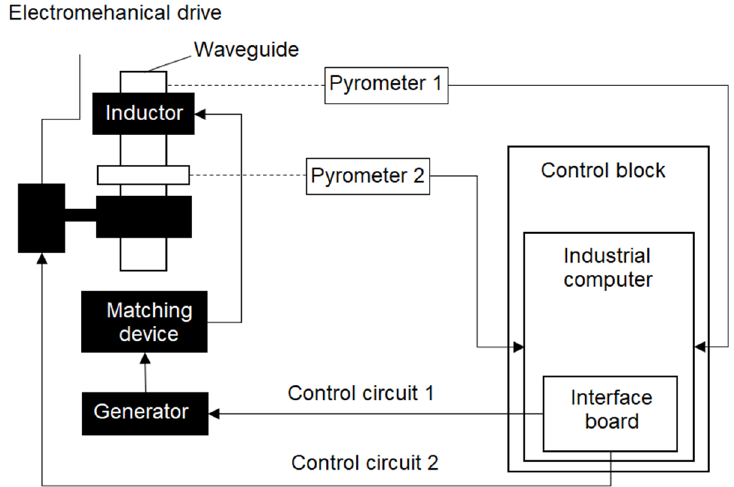
Figure 1. Functional diagram of the induction brazing unit.